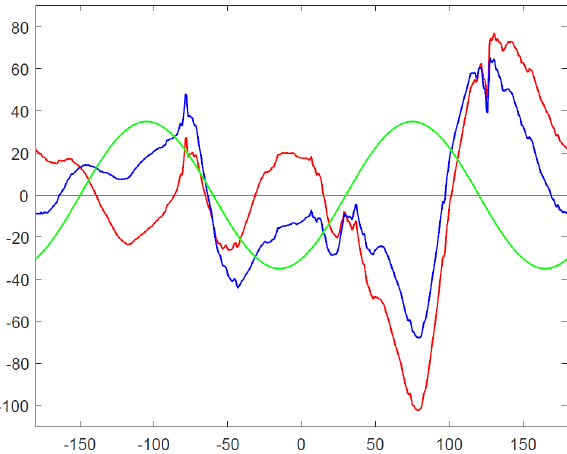
Fig. 4. Geoidal heights (in meters – vertical axis) in a cross section along equator (in degrees – horizontal axis) of model GOCO06s with respect to: i) the oblate spheroid WGS 84 (red line) and ii) the computed triaxial ellipsoid of case G-T6 (blue line). The green line illustrates the difference (in meters) of the two heights (heights given in blue line minus heights given in red